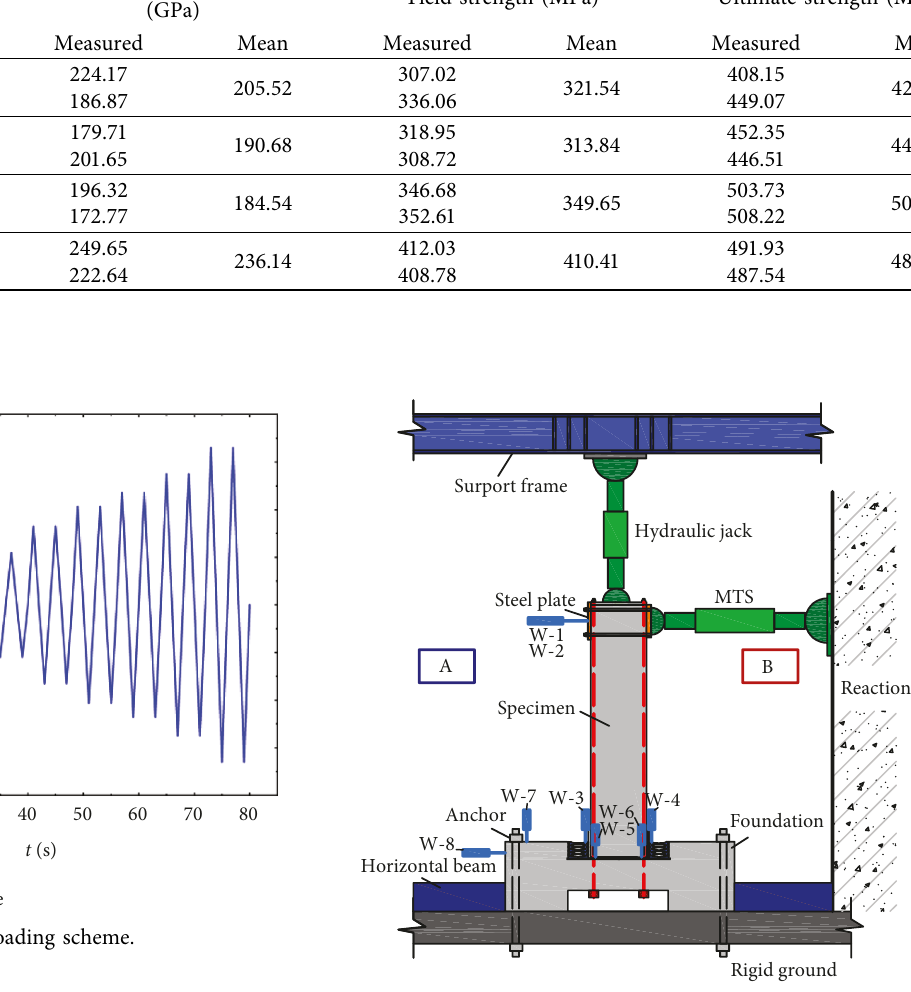
Figure 9: The schematic of pseudo-static loading test and mea- surement plan for displacement